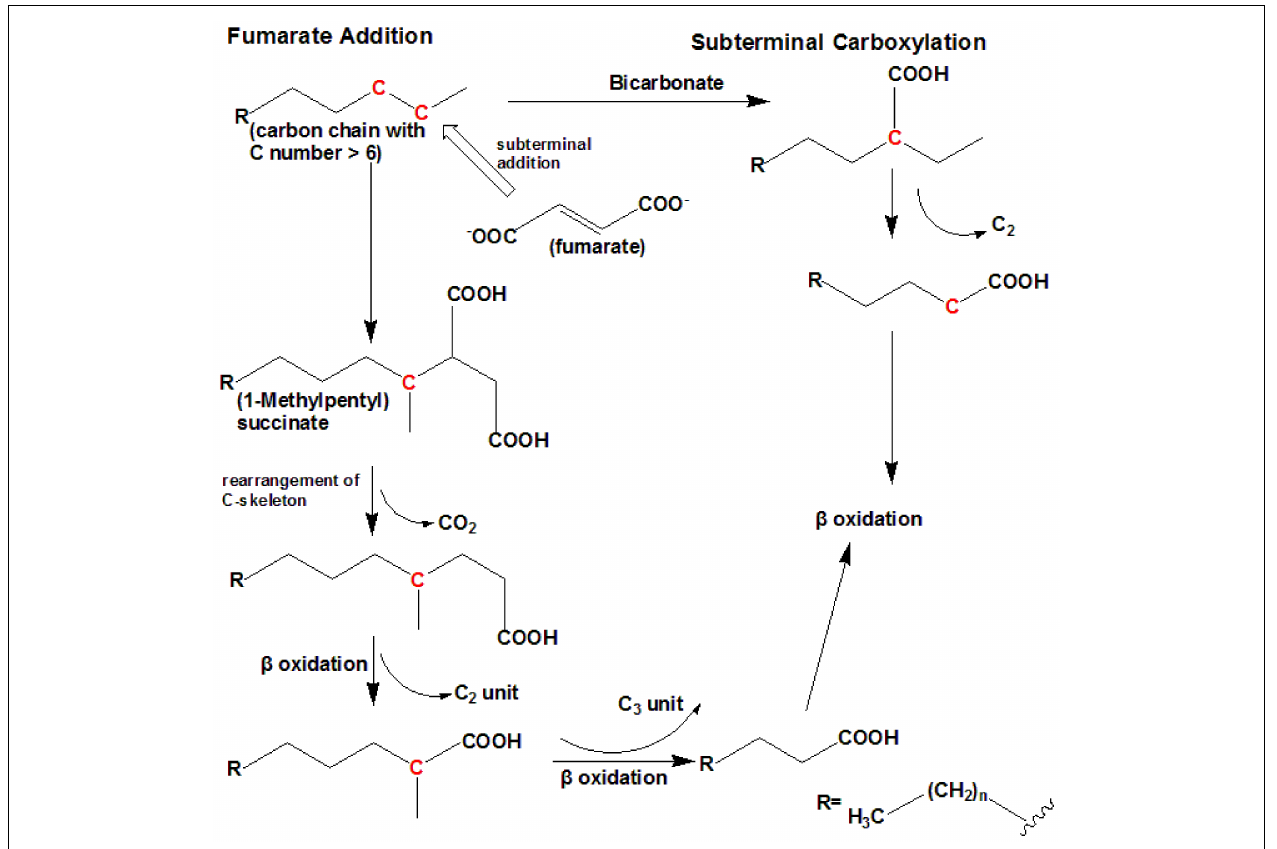
FIGURE 2 |The anaerobic degradation pathway (adapted from So etal., 2003; Cravo-Laureau etal., 2005). It shows the two types of anaerobic degradation pathway that have currently been identified.To date, subterminal